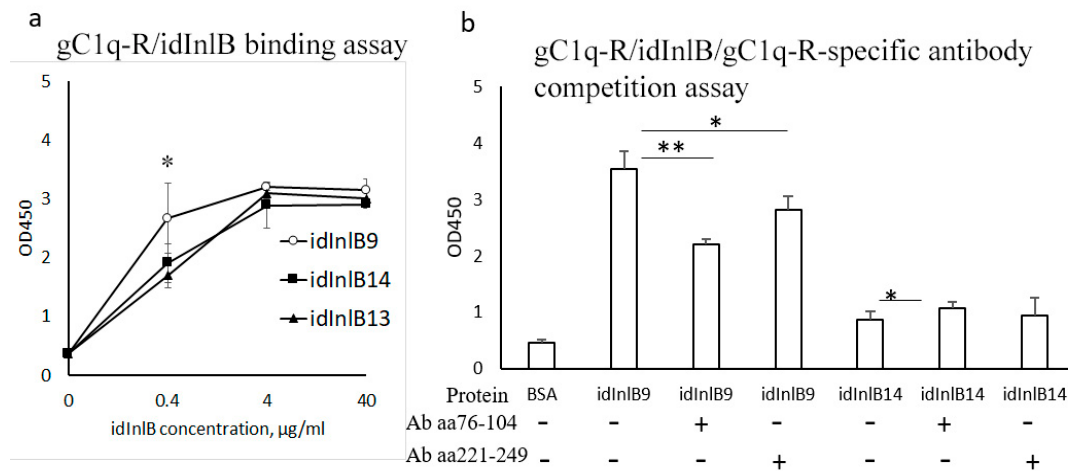
Figure 3. In vitro study of interactions between idInlBs and gC1q-R using solid-phase microplate binding and competition assay. Microtiter plate wells were coated with recombinant human gC1q-R. Purified idInlBs were added. ELISA assay was performed with His-tag-specific polyclonal antibodies and HRP-conjugated secondary antibodies. ( a ) Saturation curve demonstrating binding of three idInlB isoforms to gC1q-R; purified idInlBs were added in concentrations 0–40 µ g / mL: circles-idInlB9, triangles-idInlB13, squares-idInlB14; ( b ) a competition assay; polyclonal antibodies developed against oligopeptides specific for central (amino acids 76–104) and C-terminal (amino acids 221–249)